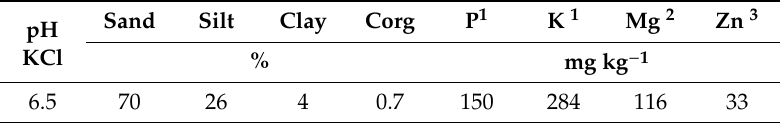
Table 1. Properties of soils used in the